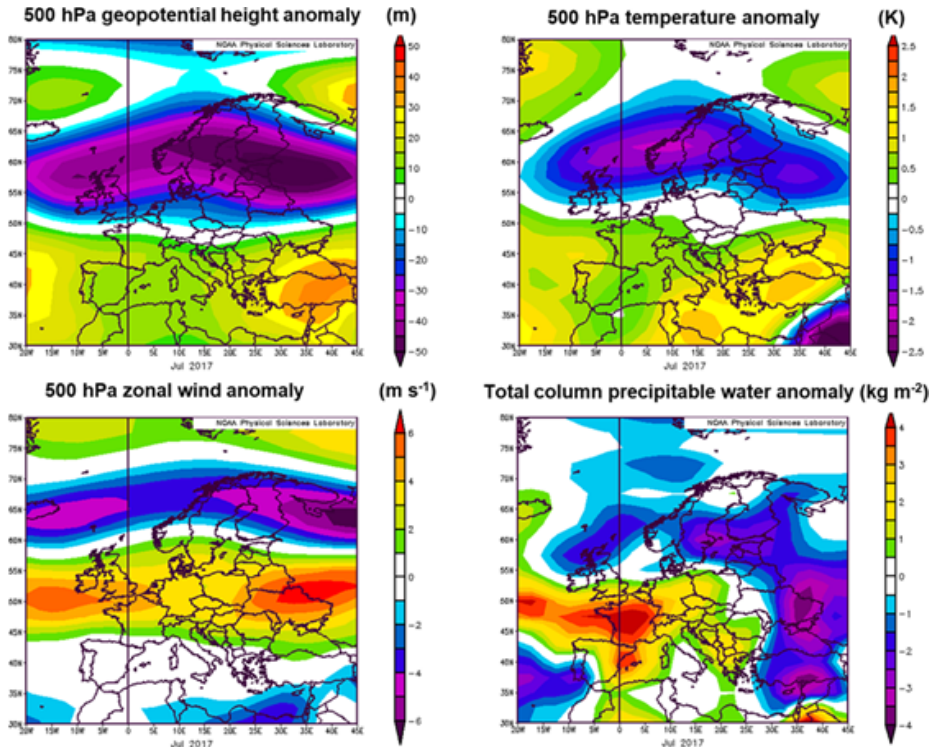
Figure 2. Mean anomalies of the 500hPa geopotential height (top left), temperature (top right), zonal wind (bottom left), and total column precipitable water (bottom right) for July 2017 with respect to a 1981–2010 July climatology based on NCEP reanalysis data (Kalnay et al., 1996). Total column precipitable water is the amount of water potentially available in the atmosphere for precipitation from the surface to the upper edge of the troposphere. NCEP reanalysis data and images are provided by the NOAA/ESRL Physical Sciences Laboratory, Boulder, Colorado (http://psl.noaa.gov/, last access: 21 September